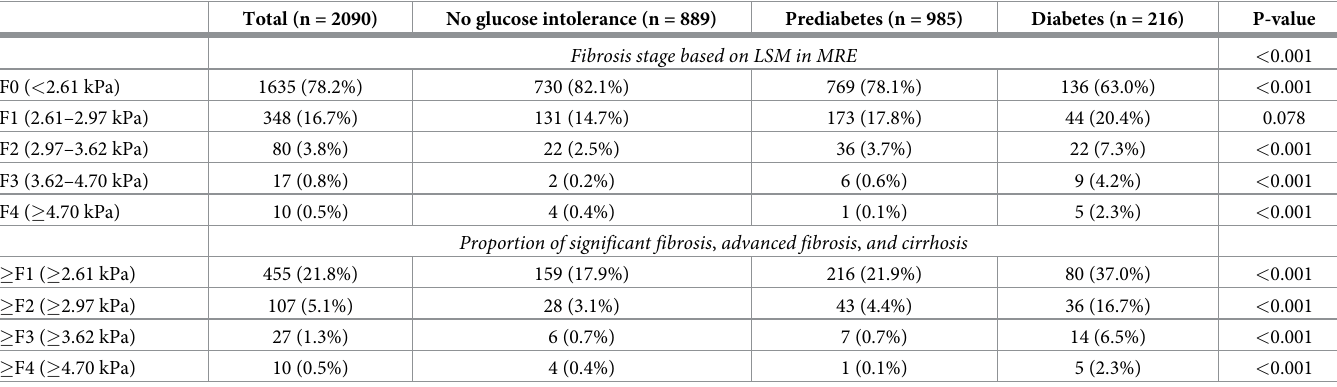
Table 2. Liver fibrosis according to glucose